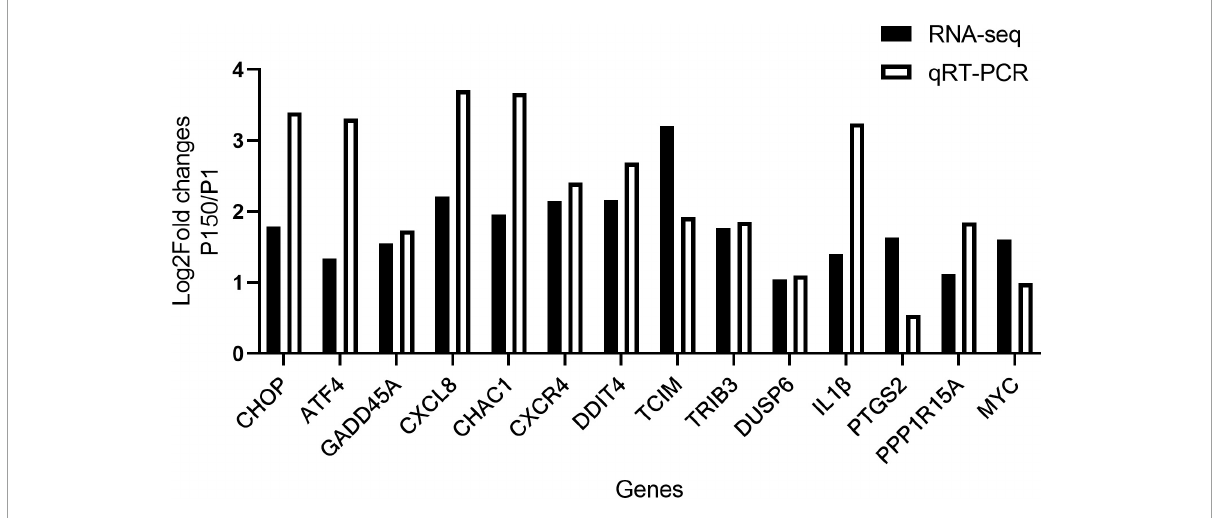
FIGURE4 Validation of RNA-seq results by qRT-PCR. Log2Fold changes (P150 vs. P1) obtained by qRT-PCR were compared with the sequencing results for 14